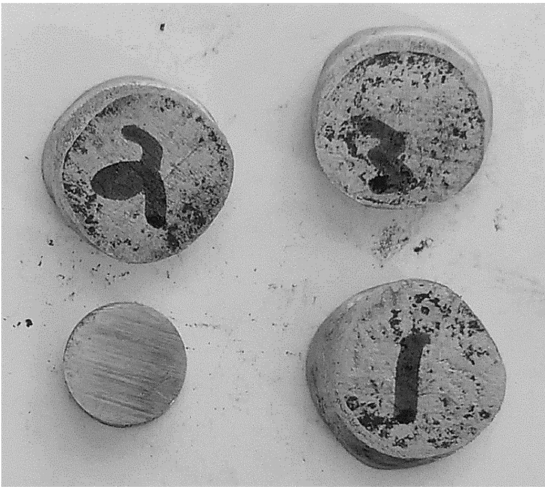
Figure 3. 0 ◦ –[010]–45 ◦ specimens after compression.